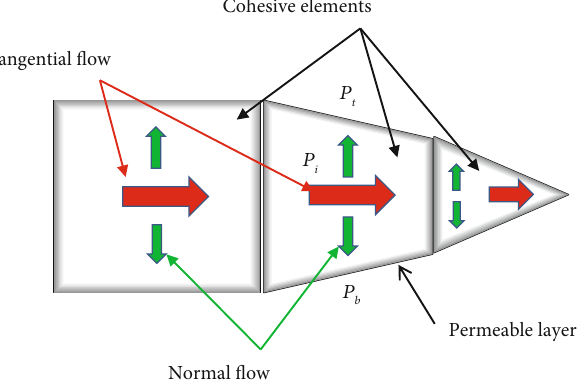
Figure 2: Flow model hydraulic